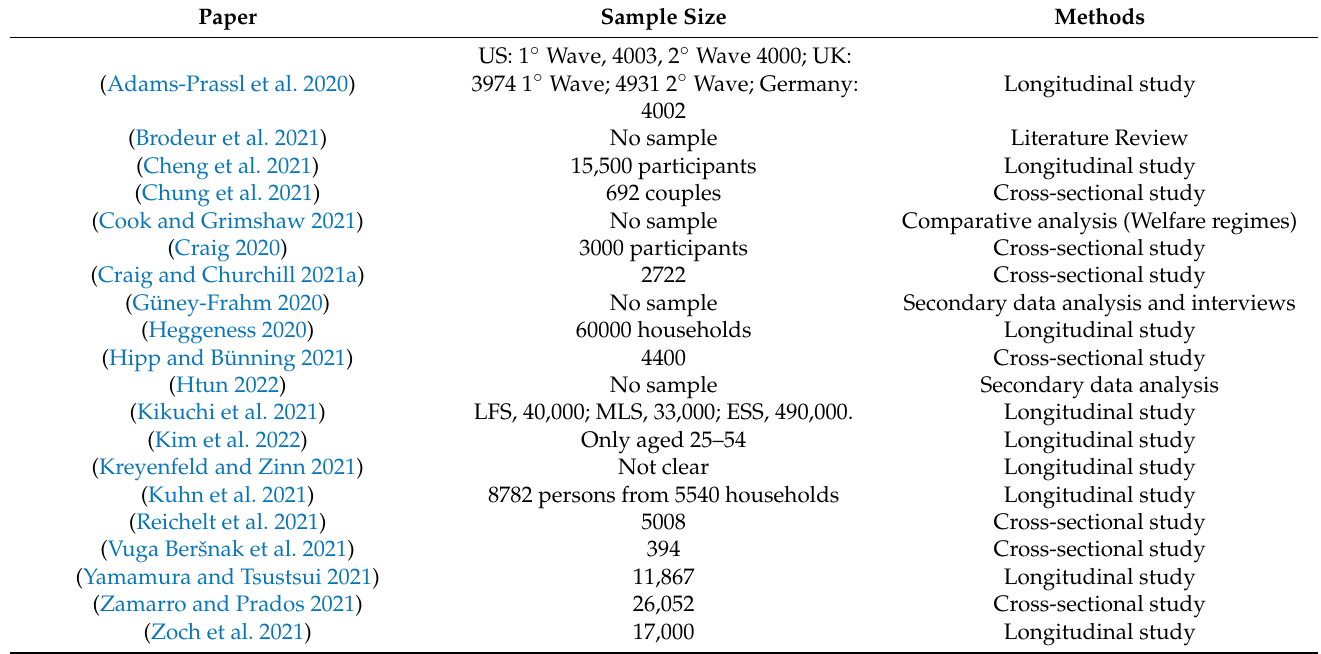
Table 3. Sample size and methods used by each